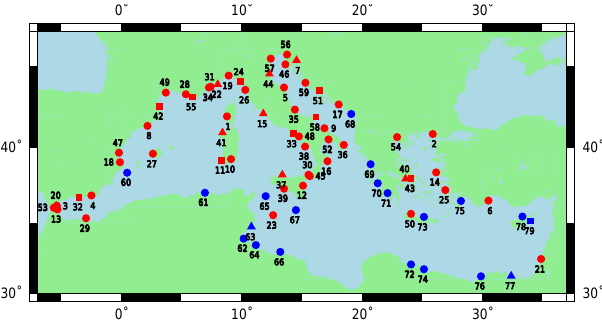
Fig. 2. Distribution of tide-gauge stations along the coasts of the Mediterranean Sea. In red the stations included in Table 1 are shown. For the stations in blue included in Table 2 tidal parame- ters for M2, S2, K1, and O1 were used from Tsimplis et al. (1995). Filled squares: gauges used in the control data set (i), filled trian- gles: gauges used in the control data set